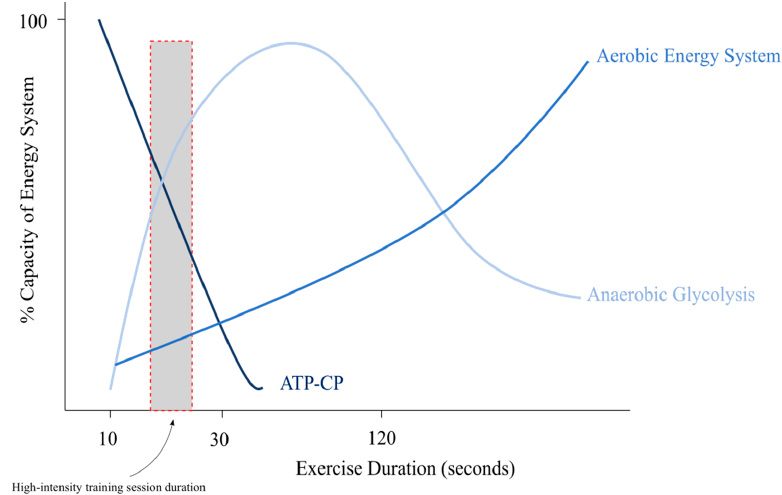
Figure 3. Training of the metabolic systems involved with energy production. During high-intensity workouts, the threshold at which anaerobic glycolysis becomes the predominant system for energy production is reached. Figure adapted from [38] .